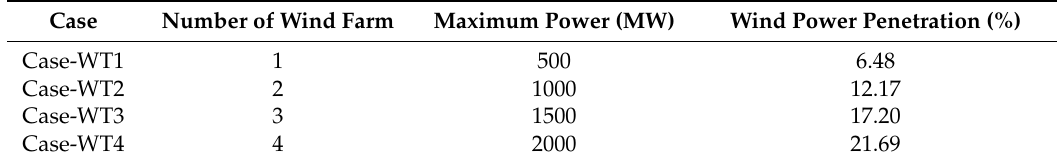
Table 5. Wind power scenarios Case-WT1, Case-WT2, Case-WT3, and